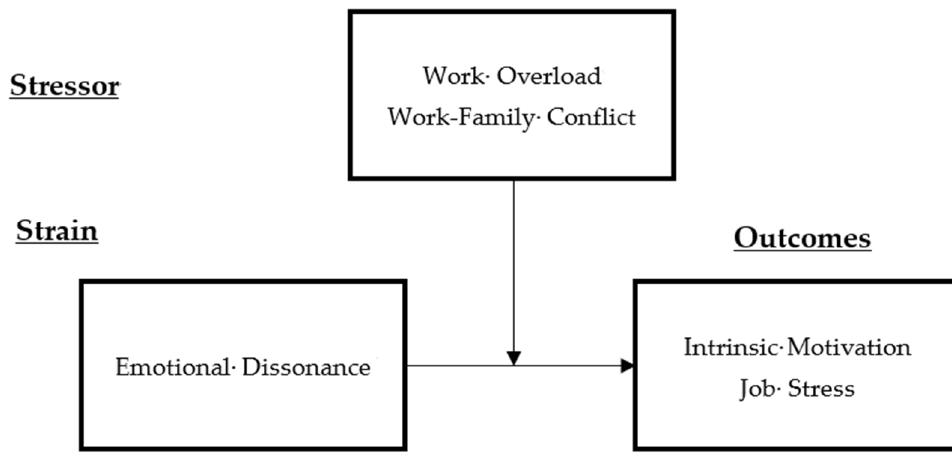
Figure 1. Conceptual